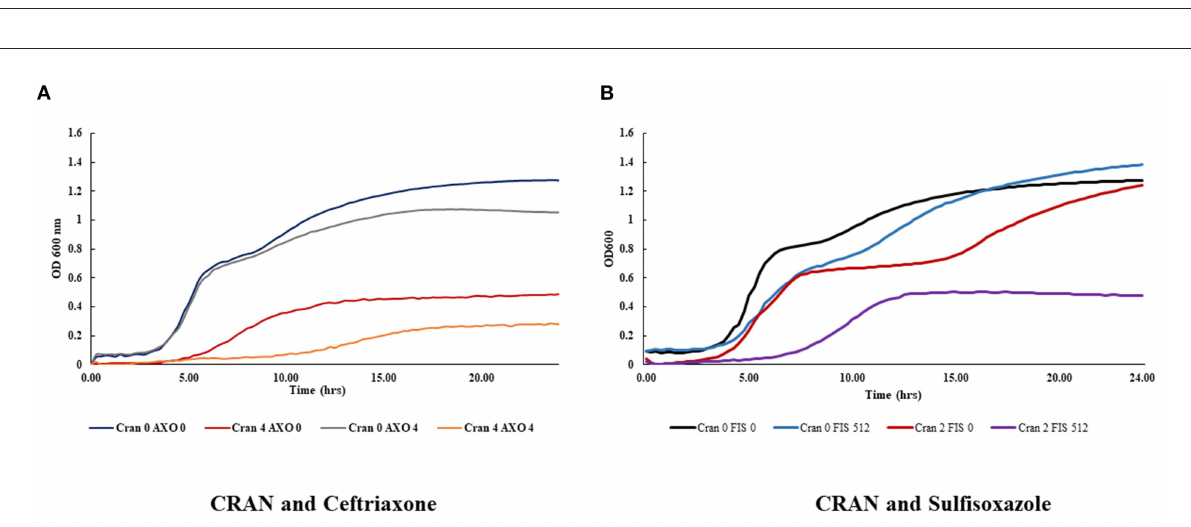
FIGURE1 Growth curve obtained using the Bioscreen C analyzer representing optical density at 600nm for (A) multidrug-resistant isolate 2532 E. coli O7:H18 (ST38) and (B) pan susceptible isolate 2440 E. coli O7:H6 (ST362). Three replicates for each concentration (0 to 16 mg/mL) of ethanolic extracts of cranberry pomace tested are represented in the legend.